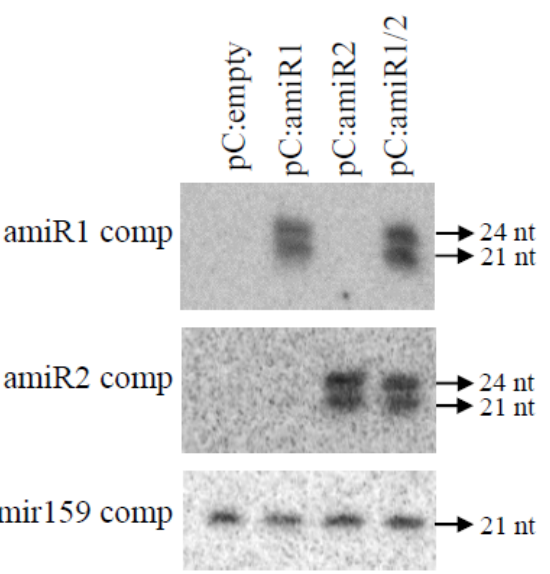
Figure 3. Northern blot detecting amiR accumulation in N. benthamiana leaves. N. benthamiana leaves were transiently transformed with empty vectors or pCambia vectors containing the amiR1 construct (pc:amiR1), amiR2 construct (pc:amiR2), or amiR1/2 construct (pC:amiR1/2). Northern blots were hybridized with amiR1 or amiR2 complementary sequences as probes (amiR1 comp and amiR2 comp). mir159 hybridization with a mir159 complementary probe (mir159 comp) was used as an equal loading control. The sizes of the detected bands are indicated.